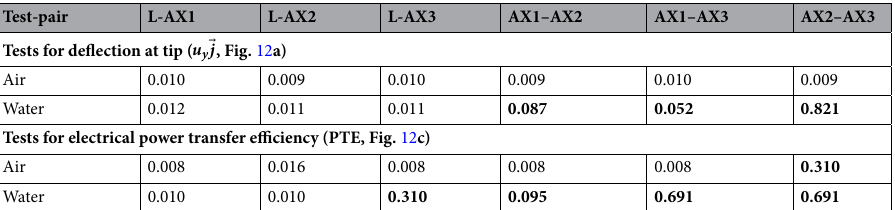
Test-pair L-AX1 L-AX2 L-AX3